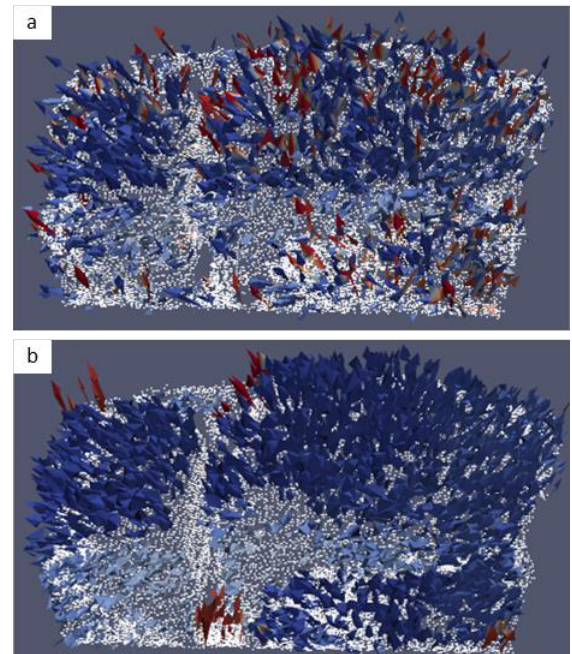
Figure 5. Visualization of normals in ParaView (Ayachit, 2015) computed with a search radius of 0.2 m (a) and 5 m